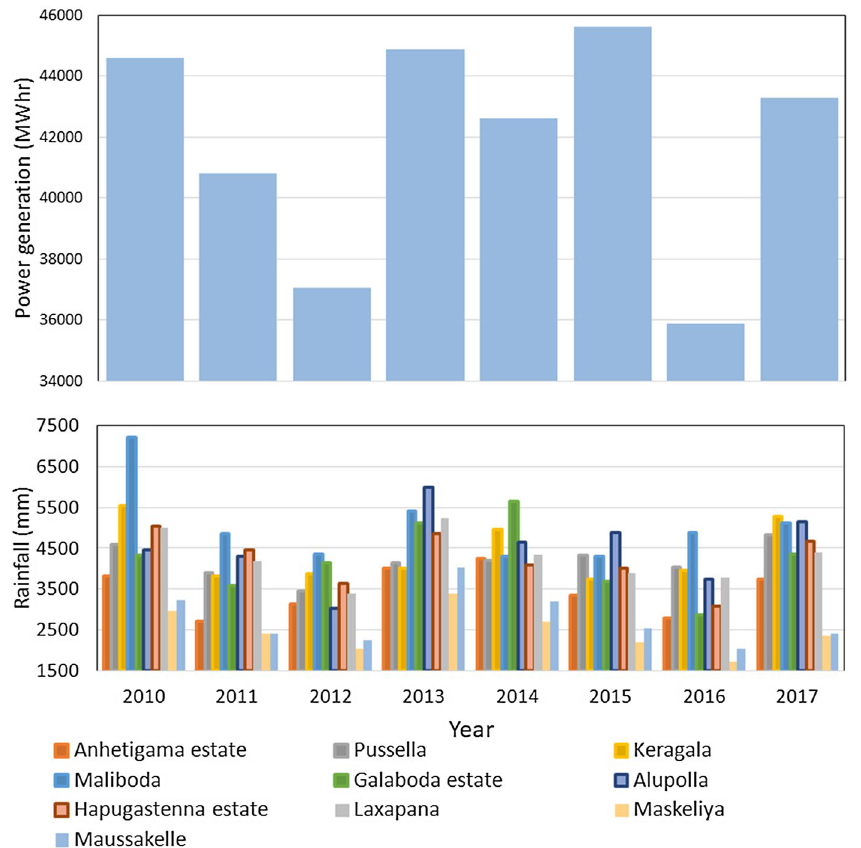
Fig. 5 Comparison of power generation against the annual